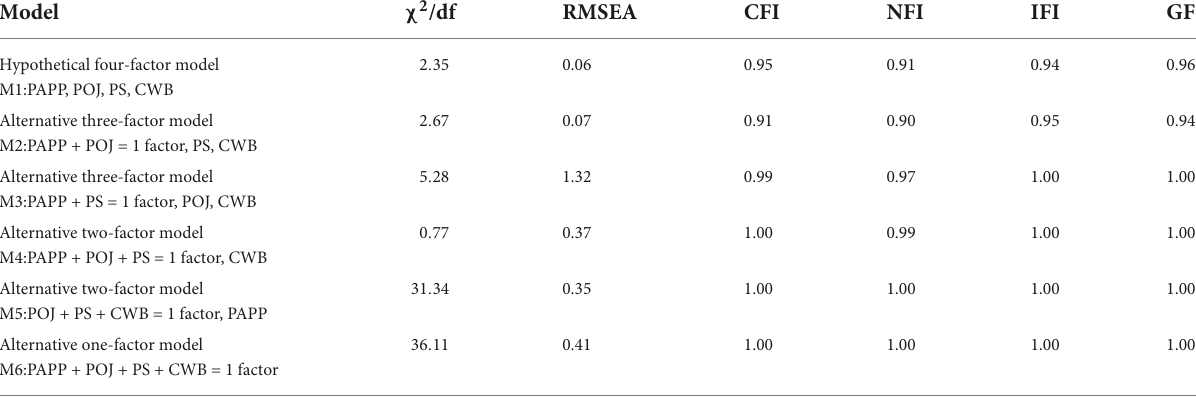
TABLE 2 Model fit summary for hypothetical model and alternative models.